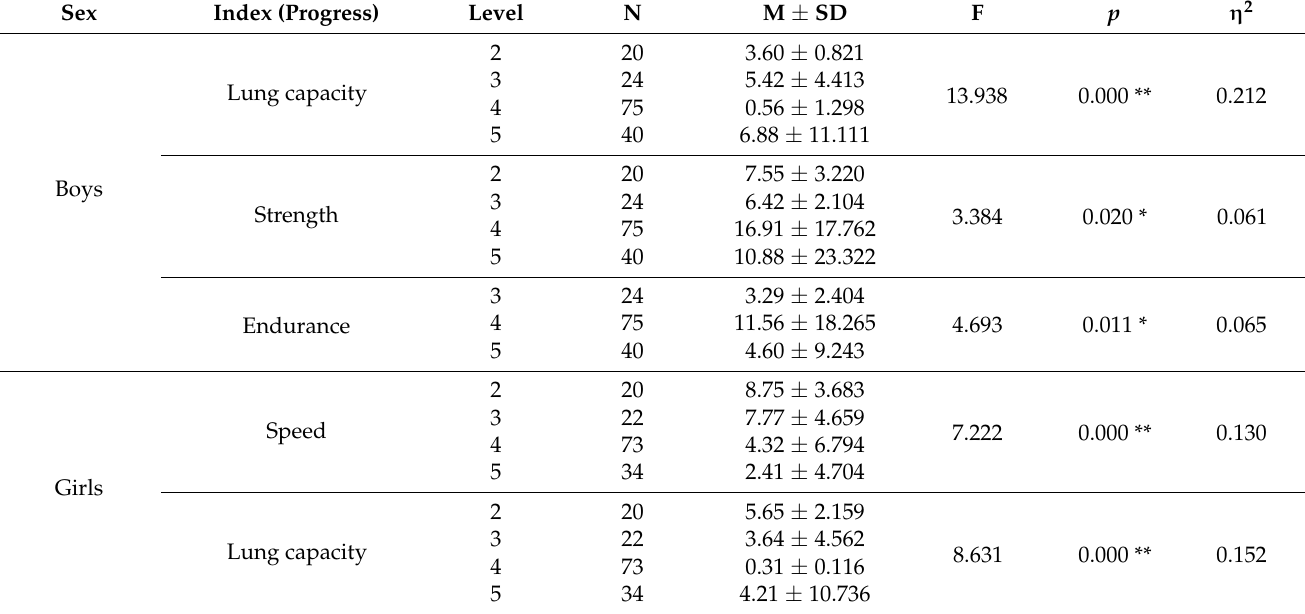
Table 8. ANOVA of progress in physical fitness scores between levels and genders.